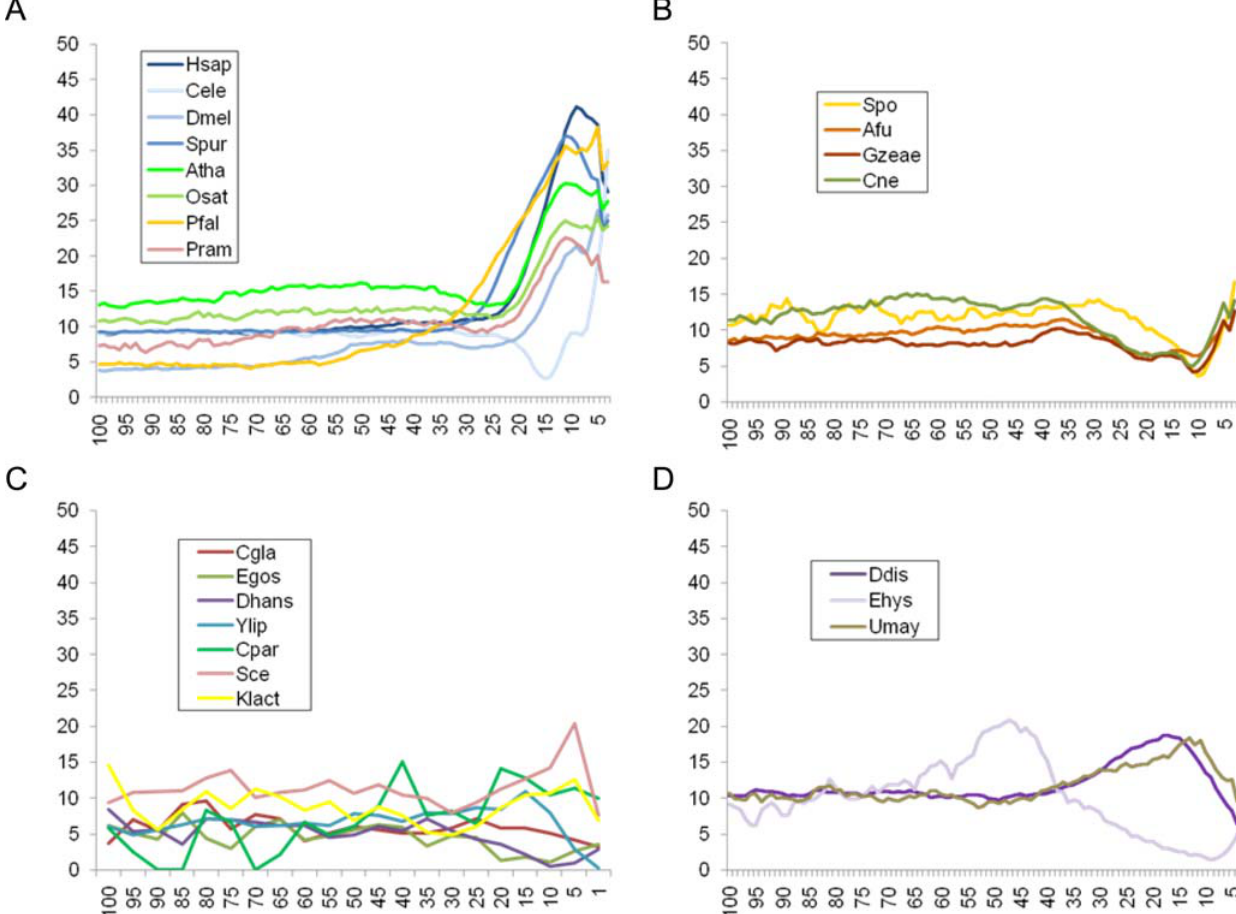
Figure 6. Characteristic patterns of polyT motif distributions across eukaryotes. Examples of: (A) Most common and widely distributed pattern. PolyT motifs concentrate at the 3 9 of the introns. Observed in plants, animals, apicomplexa and heterokonts. (B) Pattern characteristic of most fungi and in T. pseudonana , characterized by relatively uniform polyT distribution. (C) Pattern of some intron-poor species. (D) Pattern observed in amebozoa and in the fungus U. maydis . Species included in the study: Homo sapiens (Hsap); Caenorhabditis elegans (Cele); Drosophila melanogaster ( Dmel); Strongylocentrotus purpuratus (Spur); Arabidopsis thaliana (Atha); Oryza sativa (Osat); Plasmodium falciparum (Pfal); Phytophthora ramorum (Pram); Schizosaccharomyces pombe (Spo); Aspergillus fumigatus (Afu); Giberella zeae (Gzeae); Cryptococcus neoformans (Cne); Candida glabrata (Cgla); Eremothecium gossypii (Egos); Debaryomyces hansenii (Dhans); Yarrowia lipolytica (Ylip); Cryptosporidium parvum (Cpar); Saccharomyces cerevisiae (Sce); Kluyveromyces lactis (Klact); Dictyostelium discoideum (Ddis); Entamoeba hystolitica (Ehys); Ustilago maydis